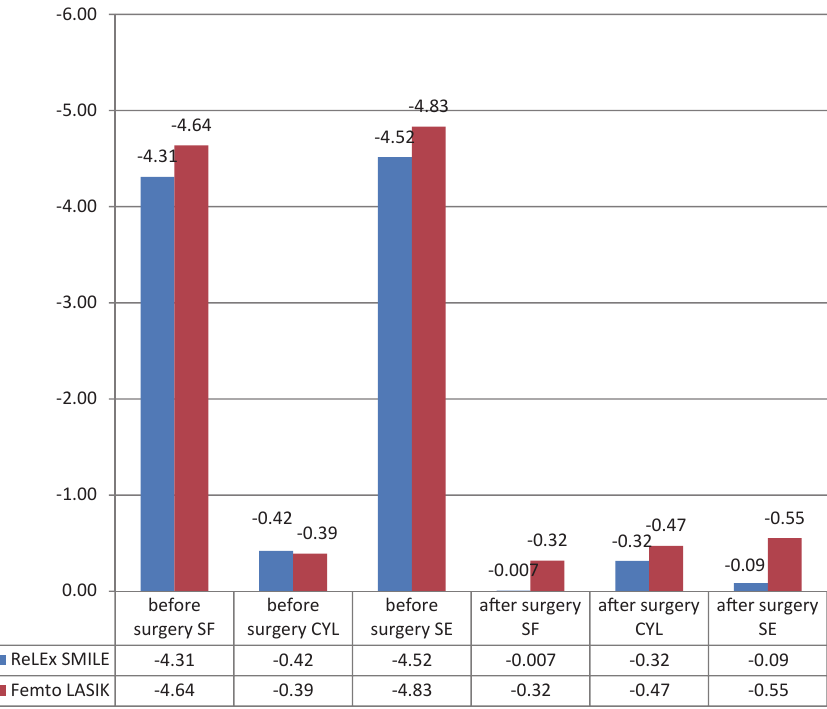
Fig. 2. The average postsurgical visus of both eyes after femtoLASIK and ReLEx SMILE. X axis: time horizon observation. Y axis: UCVA values 2 .